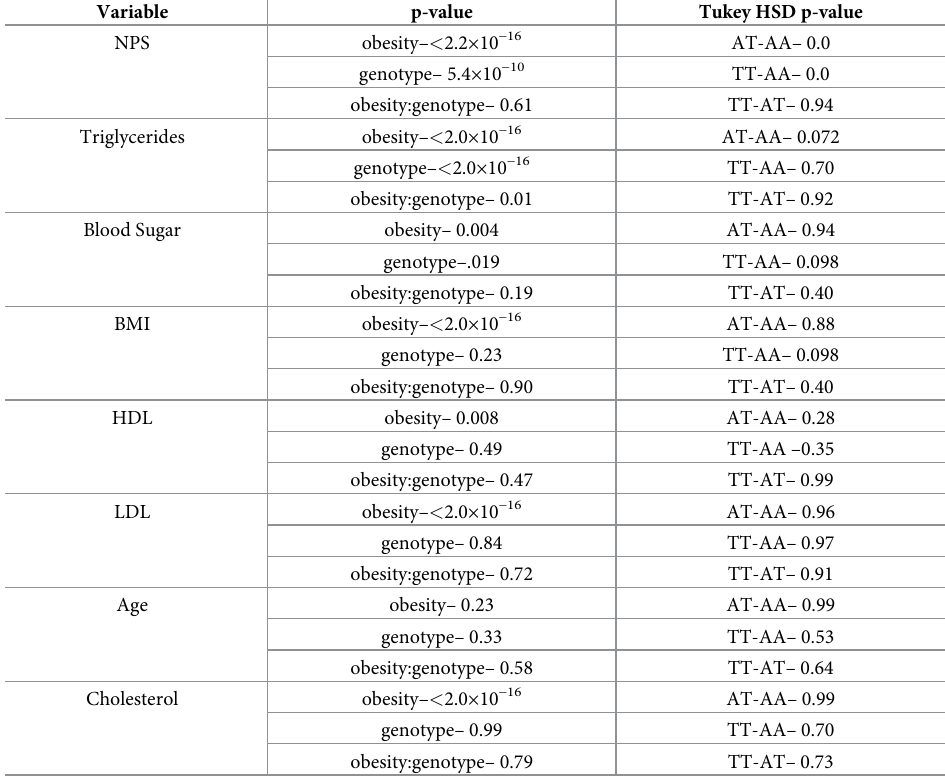
Table 3. Comparison of independent variables obesity and genotype against dependent variables (NPS, triglycer- ides, blood sugar, BMI, HDL, LDL, age and cholesterol) by two-way